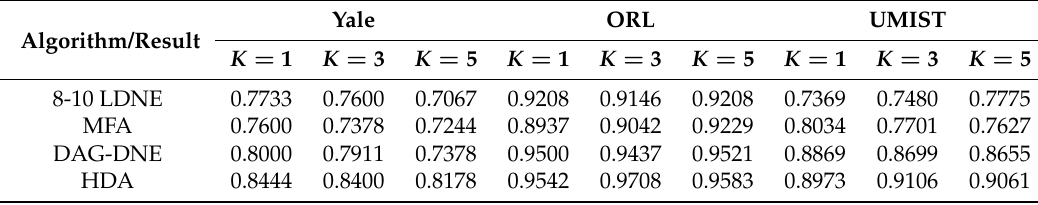
Table 1. Performance comparison of the algorithms on three datasets with different numbers of K